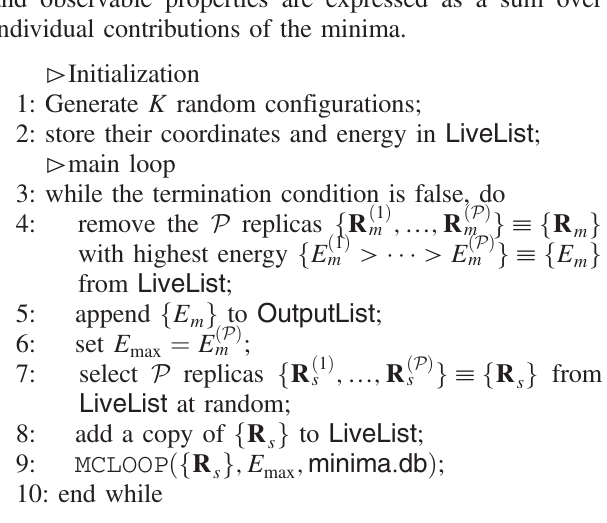
ALGORITHM 1. Nested sampling MCLOOP . ALGORITHM 2. Parallel nested